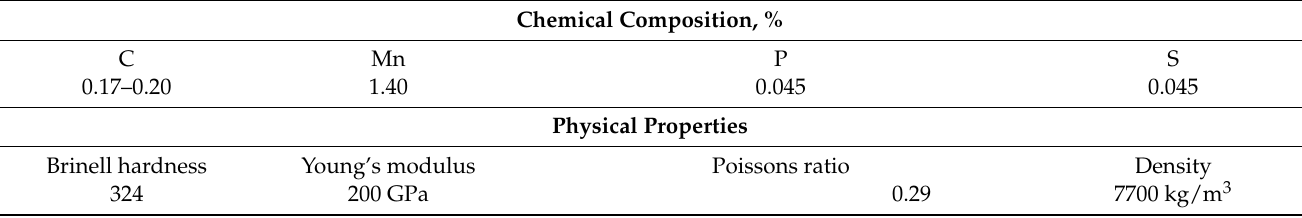
Table 3. Chemical composition and mechanical properties of 1.0037 type